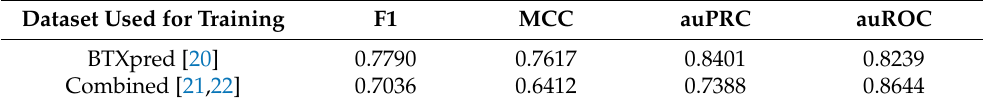
Table 6. Test data